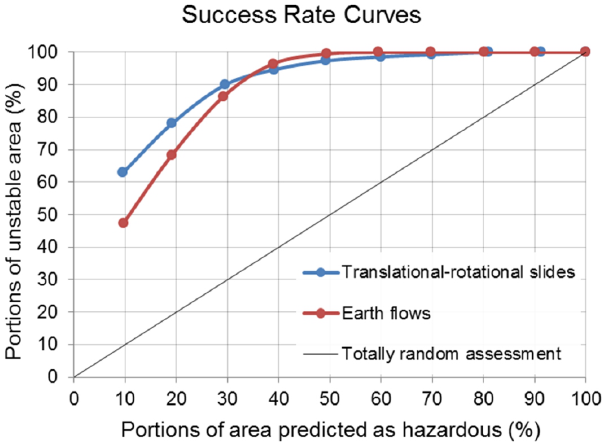
Figure 4. Distribution of plasticity zones during Carrè landslide in the case of the water table at the ground surface. Insets show the direction of displacement vectors in different parts of the landslide body.